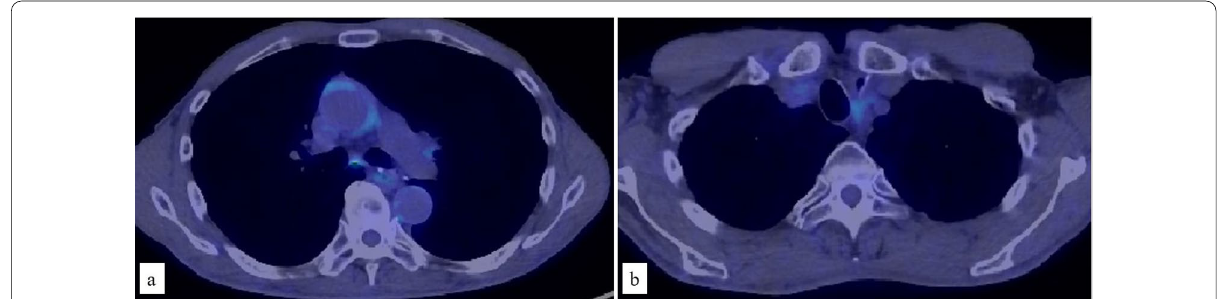
Fig. 4 Positron emission tomography–computed tomography imaging at the delayed phase to evaluate the treatment response. a , b Disappearance of all lesions after 10 cycles of nivolumab in combination with radiotherapy (56